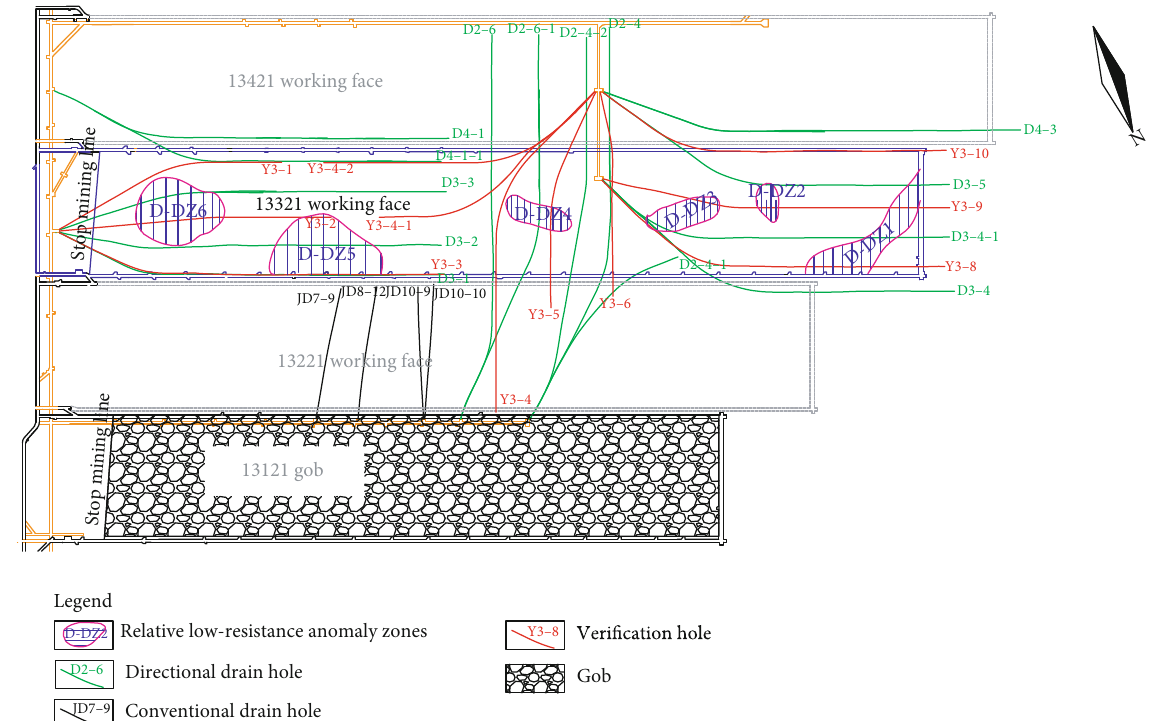
Figure 7: Comprehensive geophysical abnormal interpretation of 13321 working face fl oor and holes for regional control veri fi cation